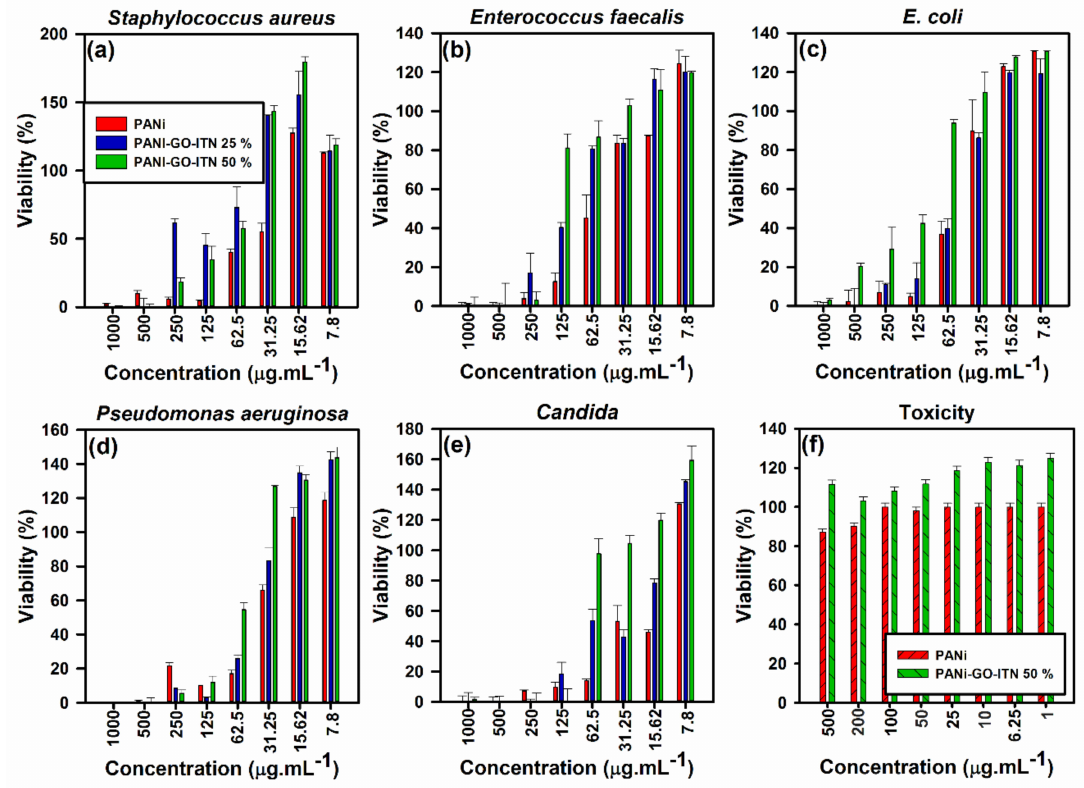
Figure 10. Performance of the developed shields against ( a ) Staphylococcus aureus , ( b ) Enterococcus faecalis , ( c ) E. coli , ( d ) Psedomonas aeruginosa , and ( e ) Candida along with ( f ) toxicity evaluation of PANi and reinforced PANi with 50 wt % GO-ITN. Table 2. MIC and MBC / MFC values of the developed shields against selected microorganisms.